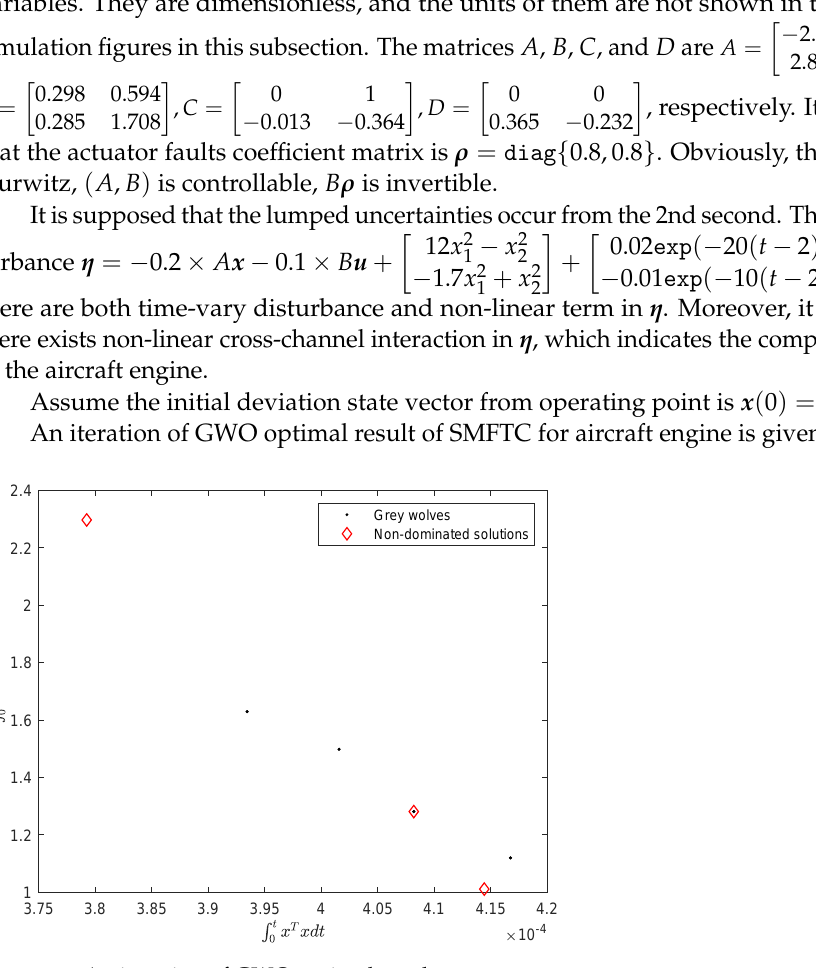
Figure 13. An iteration of GWO optimal